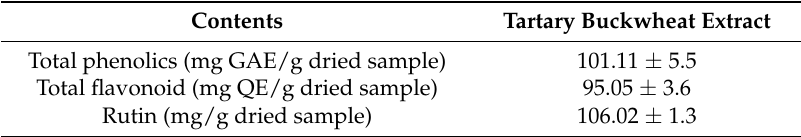
Table 2. Bioactive compounds found in tartary buckwheat extracts.